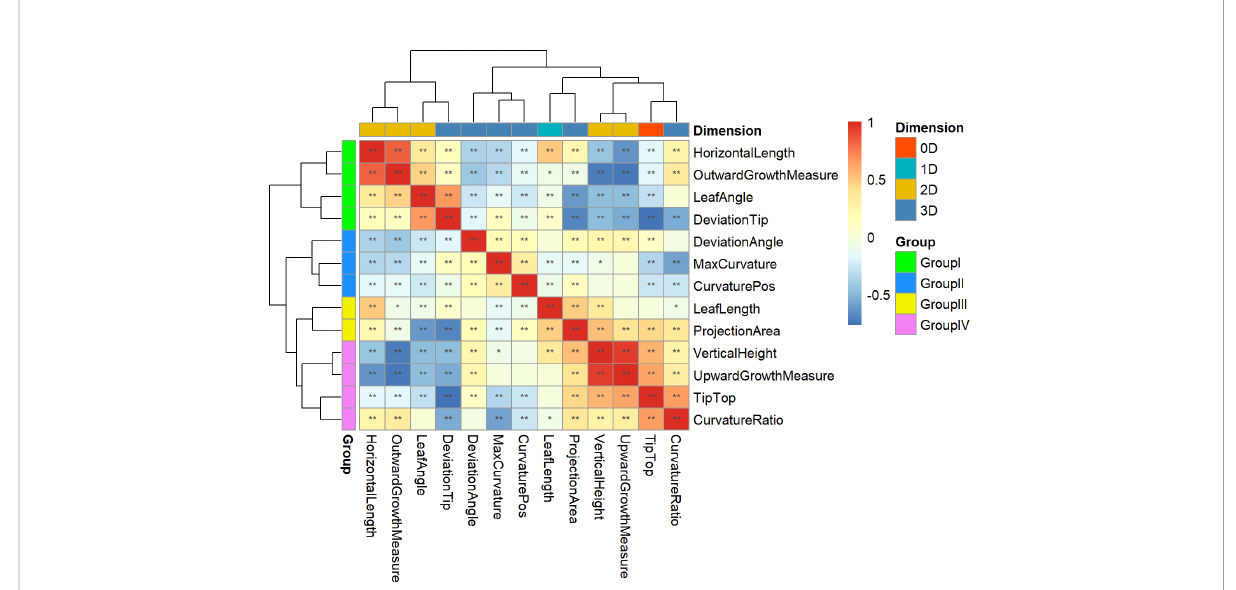
FIGURE 9 Clustering and grouping of 13 key leaf midrib curve traits. 13 traits covering four dimensions were divided into four groups and marked with different colors: Group I, Group II, Group III, and Group IV. *, P-value<0.05; **,